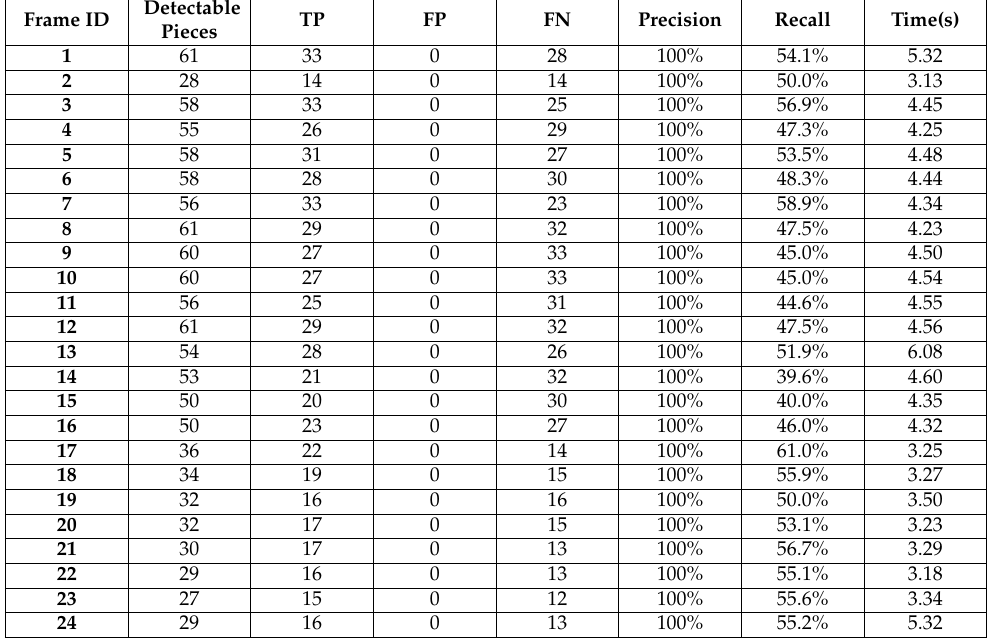
Table 3. A quantitative evaluation of LCCPLocalization service on a dataset with 24 frames. Frame